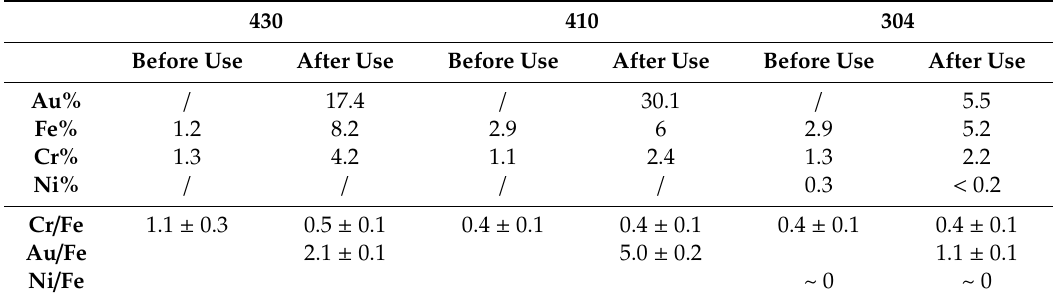
Table 1. Surface chemical composition of steel surfaces before and after their use, obtained by XPS. The main elements are reported; the complete dataset is shown in Table S1. Error is expressed as the larger value between the error associated to a single quantification and one standard deviation; error on Fe, Si, Cr, Ni and Au percentages is ± 0.2%; error on the abundance of other elements is ± 0.5%. Cr / Fe, Au / Fe and Ni / Fe ratios of the same samples are showed, as well. 430 410 304 Before Use After Use Before Use After Use Before Use After Use Au% / 17.4 / 30.1 / 5.5 / / / / 0.3 <